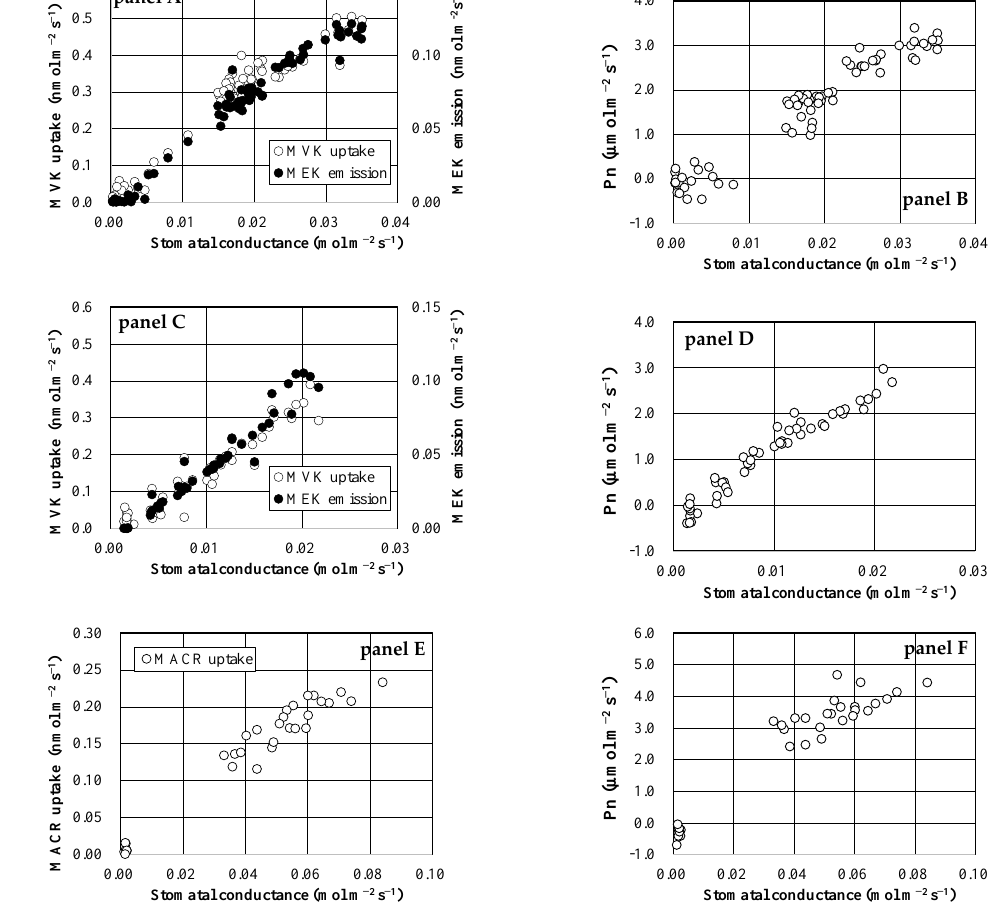
Figure 3. Relationship of exchange rates of VOCs and net photosynthetic rate (Pn) to stomatal conductance. Panels A and B: MVK fumigation experiment using Spathiphyllum clevelandii ; panels C and D: MVK fumigation experiment using Quercus acutissima ; panels E and F: MACR fumigation experiment using Quercus myrsinifolia